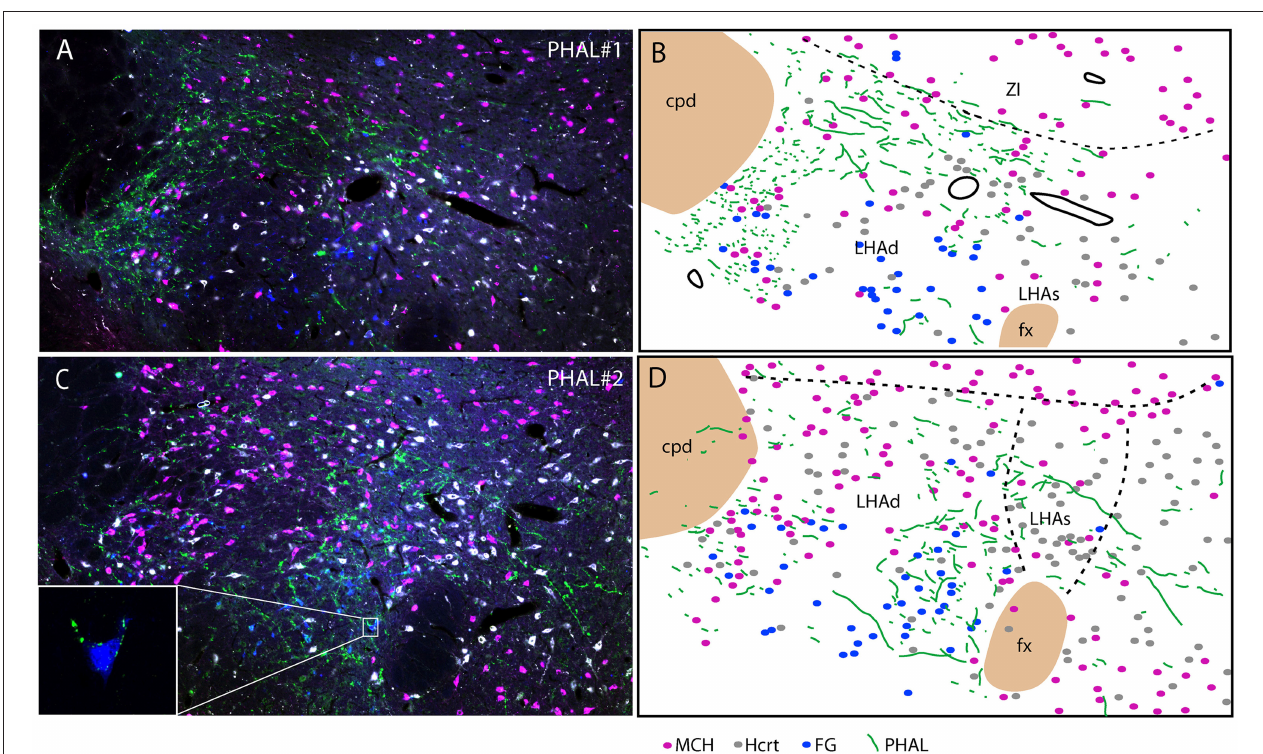
FIGURE 6 | Photomicrographs after quadruple labeling experiments with the detection using immunofluorescence of PHAL, MCH, and Hcrt, the fourth signal being the native fluorescence of the FG. Because it is difficult to separate signals from each other on the picture, we added line drawings that schematize the distribution of these signals. Sections are from experiments PHAL#1 (A,B) or PHAL#2 (C,D) respectively, and pass approximately through the level 28. Note that the PHAL distribution is distinct in these two cases, with an innervation restricted to the LHAd in experiment PHAL#1, while the LHAs is innervated in the experiment PHAL#2. Furthermore in this experiment, innervation of FG retrogradely labeled neurons from the PSTN are observed. In fact in a few occasion we could see PHAL axons forming pericellular nets around FG-containing cell bodies lateral to the fornix [framed picture in (C) , optical slice taken using the Apotome feature of the microscope]. FG labeled neurons were observed lateral to the fornix, in an area that belong to the LHAd, and in the far ventrolateral LHA. However, we cannot rule out the possibility that the labeling of these far latero-ventral neurons could not be the result of an uptake of the FG through dendrites extending into the injection site. In the two experiments, as in the experiment AMY1, only passing axons seemed to contact MCH or Hcrt cell